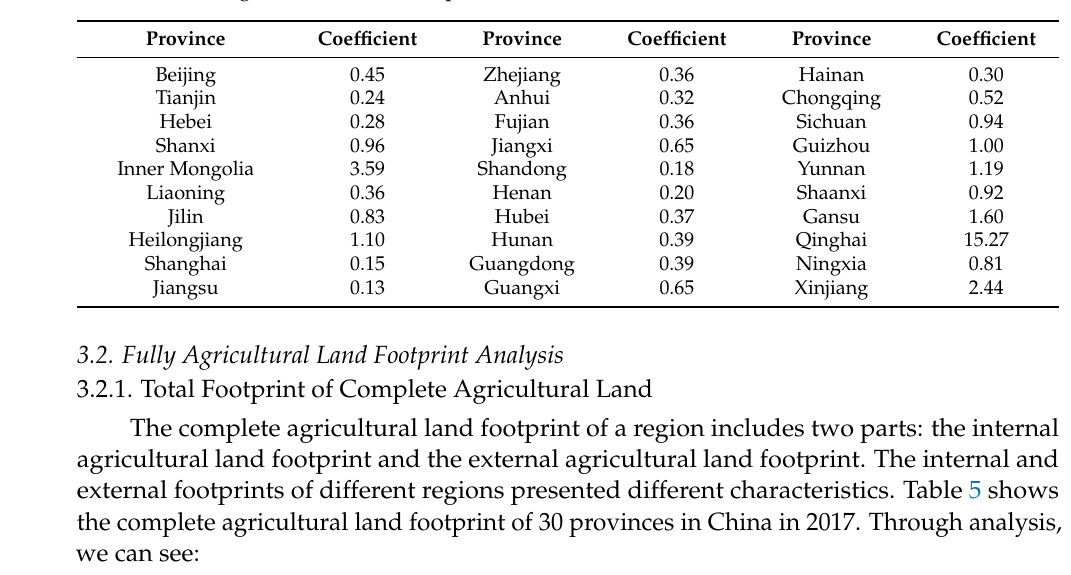
Table 4. Direct agricultural land occupation coefficients (ha/CNY 10 4 ).